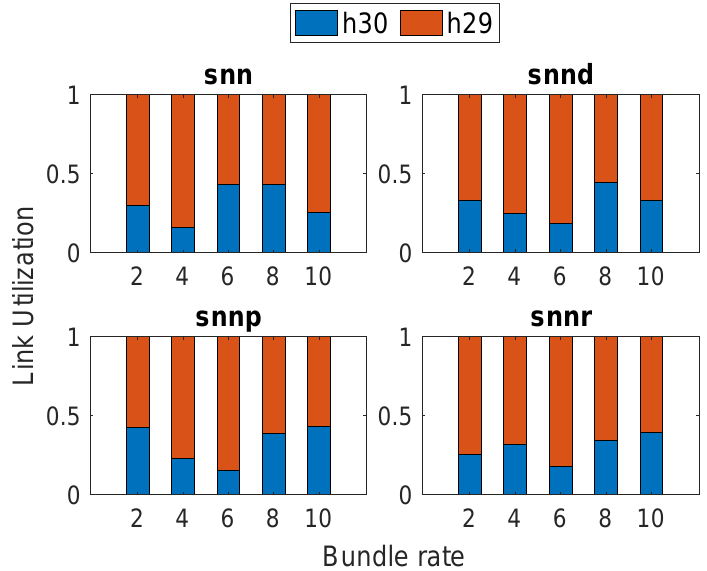
Figure 4. Link selection at Node h26: Scenario 1.